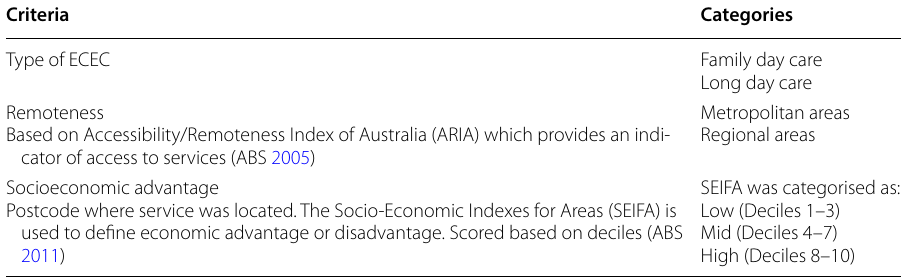
Table 1 Criteria used for stratification of ECEC